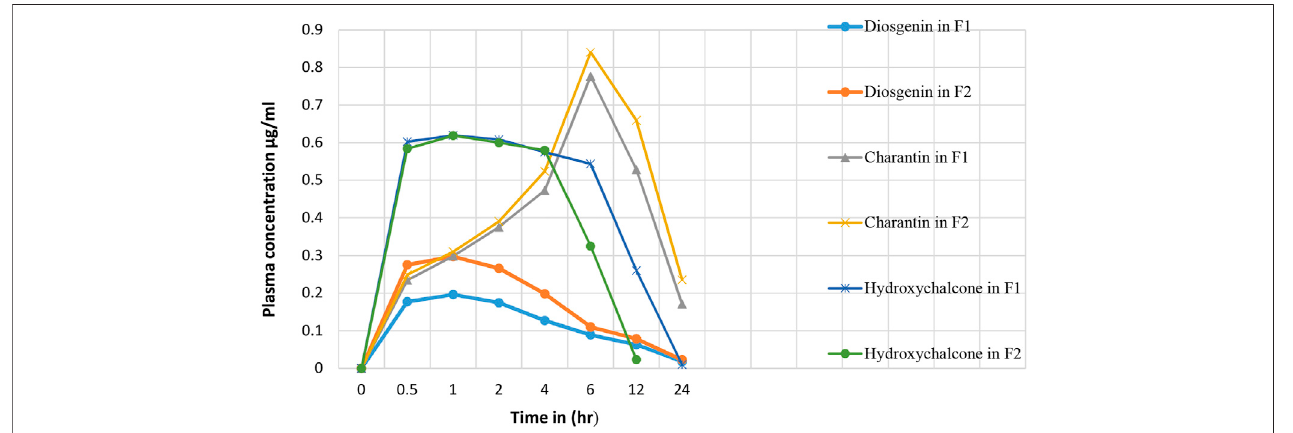
FIGURE 5 | Effect of piperine in herbal formulation on the plasma drug concentration of diosgenin, charantin, and hydroxychalcone.